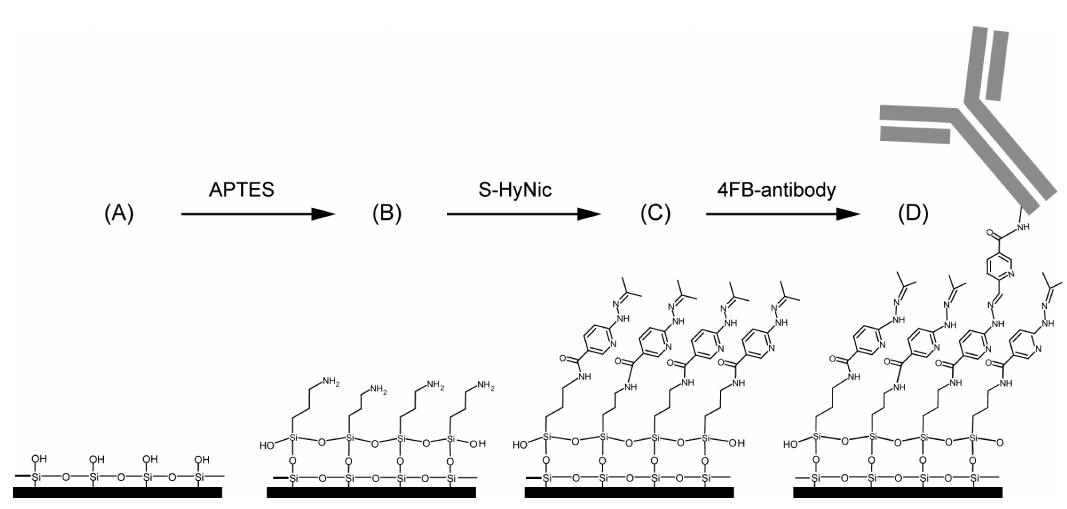
Figure 5. Representative example for surface functionalization. ( A ) Silicon surface of an activated SOI ring resonator. ( B ) In order to generate an amino-terminated surface, APTES is reacting with the surface siloxane groups. ( C ) Afterwards, S-HyNic is reacting with primary amines to build a HyNic-displaying surface. ( D ) Finally, the addition of 4FB-modified antibodies leads to a hydrazone bond formation between the 4FB moieties on the antibodies and the HyNic moieties on the surface. Reprinted (adapted) with permission from Ref. [72]. Copyright (2018) American Chemical